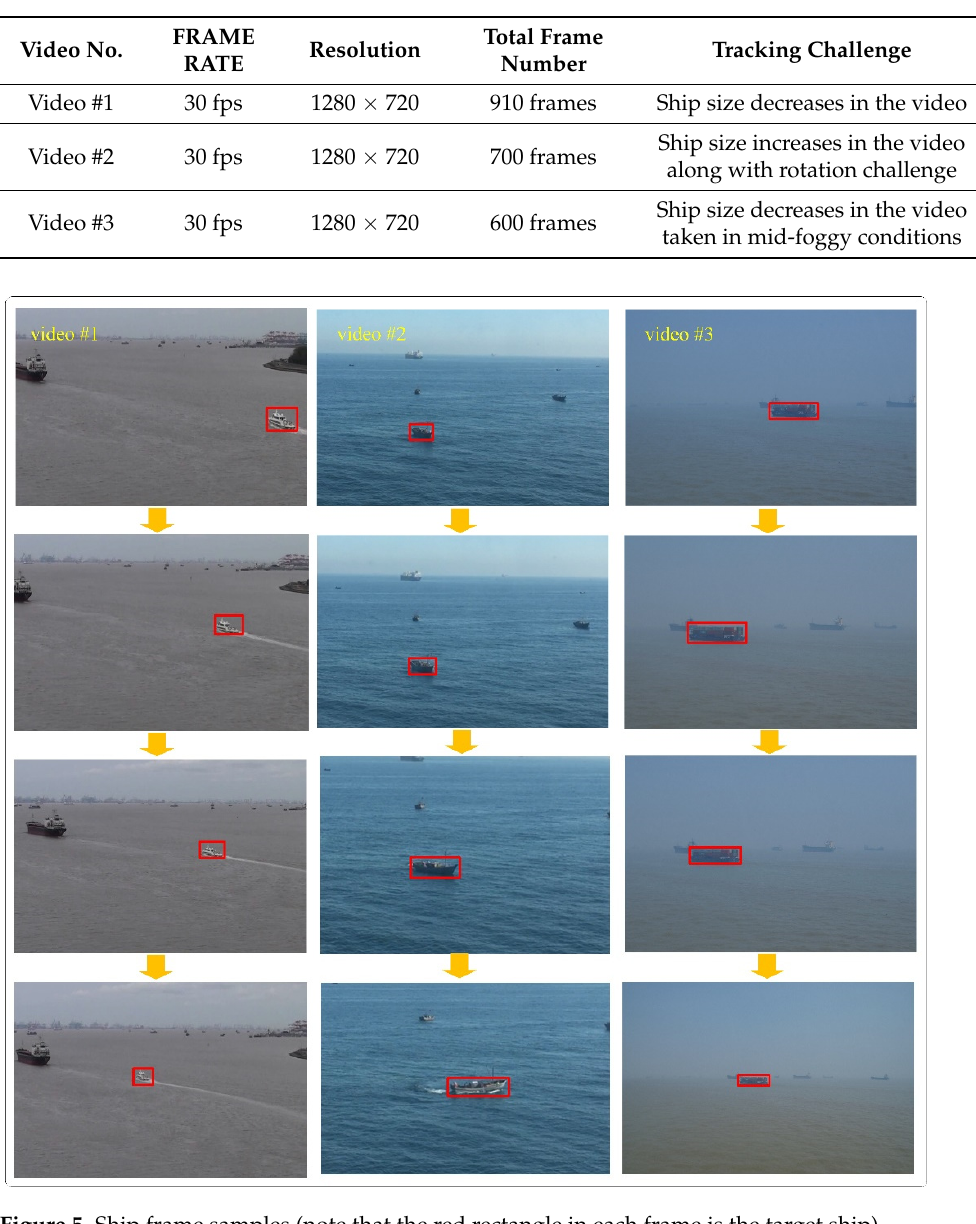
Table 2. Detailed information for the three ship video clips.